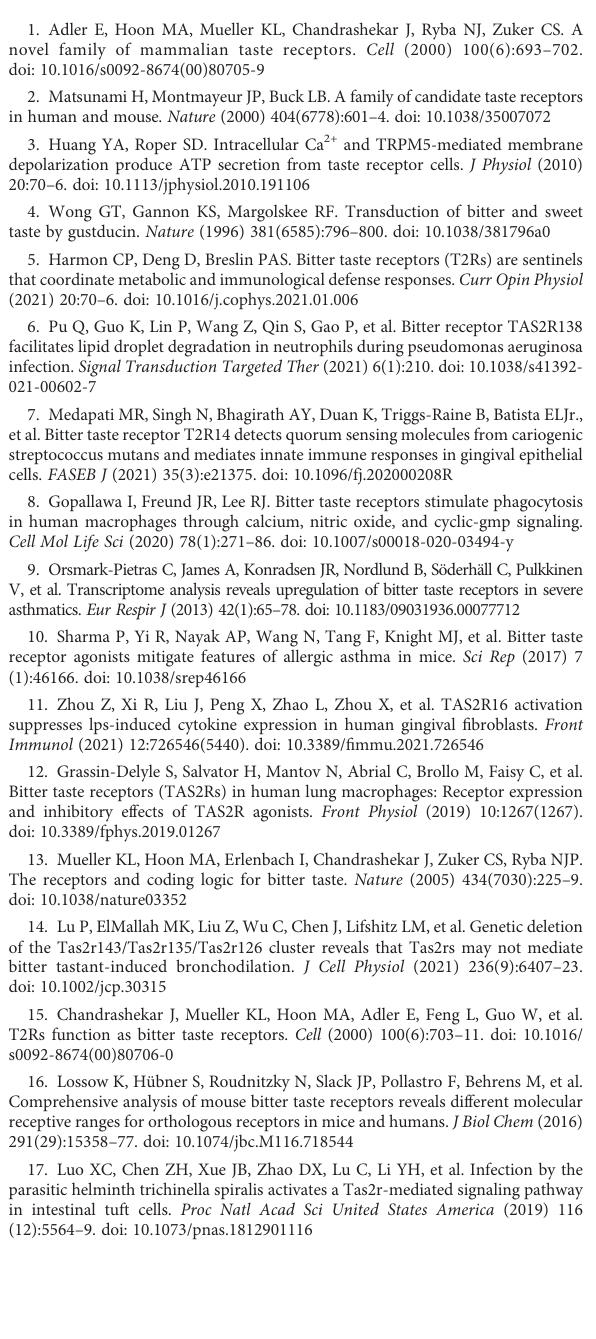
SUPPLEMENTARY FIGURE 6 Arbutin enhances neutrophil in fi ltration in a zymosan-induced peritonitis modelinaTas2R126/135/143-independentmanner. (A) Wild-typeC57BL/ 6 mice were injected IP with the indicated amount of zymosan in 0.5 ml sterile saline. In fi ltrated neutrophils in peritoneal lavage fl uid were collected 6 h later and enumerated by FACS analysis. Data represent the mean ±SEM of three mice. (B, C) Wild-type C57BL/6 mice (B) and Tas2r126/135/143 − / − mice (C) were injected IP with saline, 2 m g zymosan,